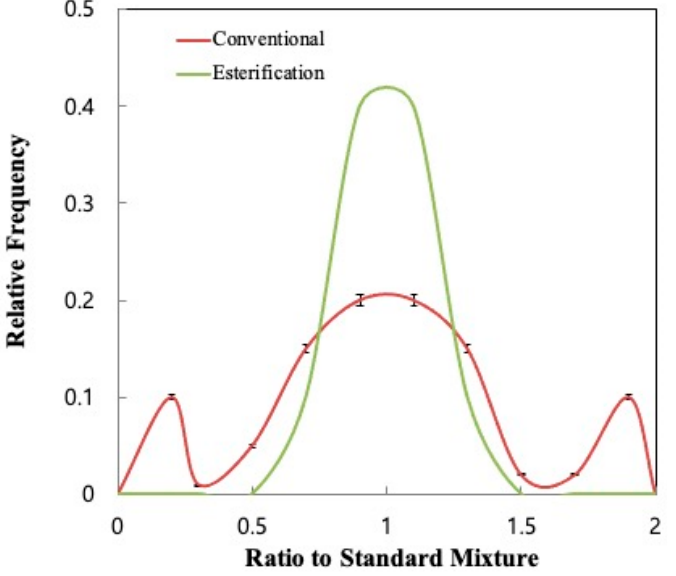
Figure 4. Ratio of the measured concentration to the known one for each component of the standard VFA solution, comparing the catalytic esterification reaction method to the conventional method.